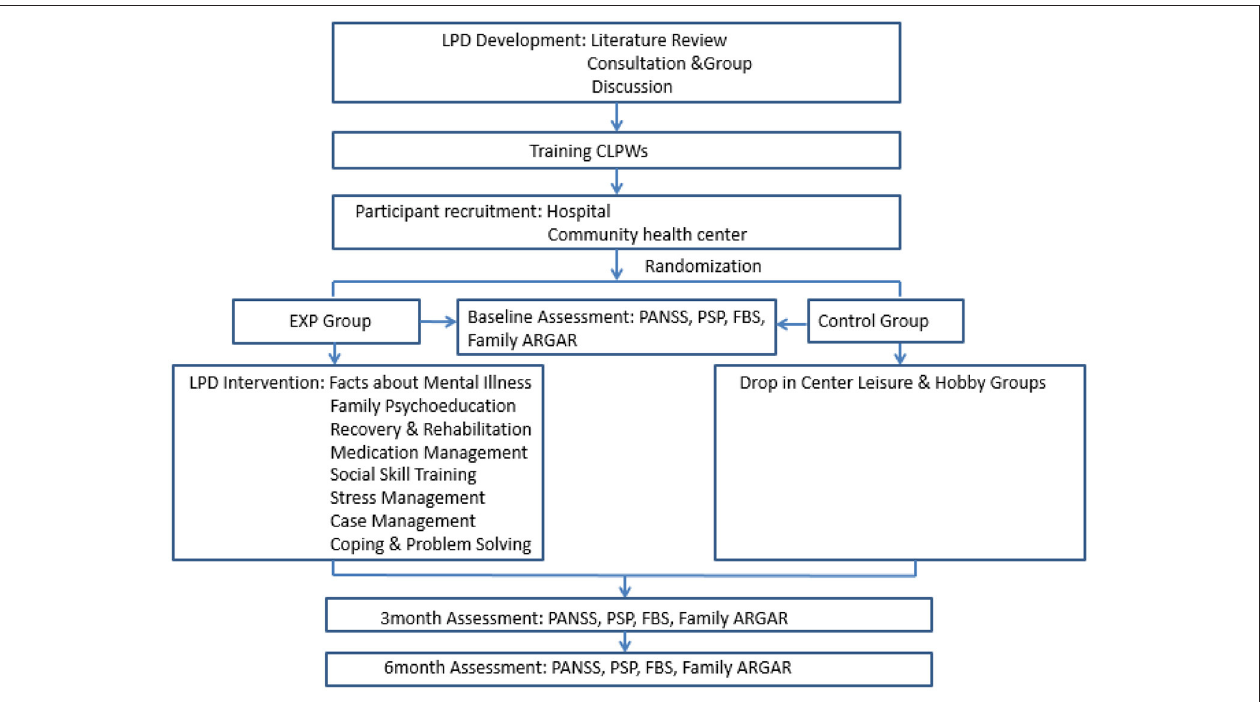
FIGURE 1 | Flowchart of the study (LPD psychiatric rehabilitation